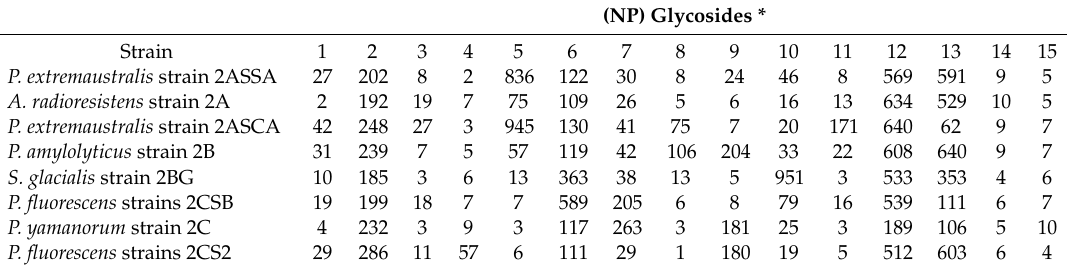
Table 4. Glycoside hydrolase (GH) activities detected through nitrophenyl (NP) glycosides in the extracellular compartment of selected